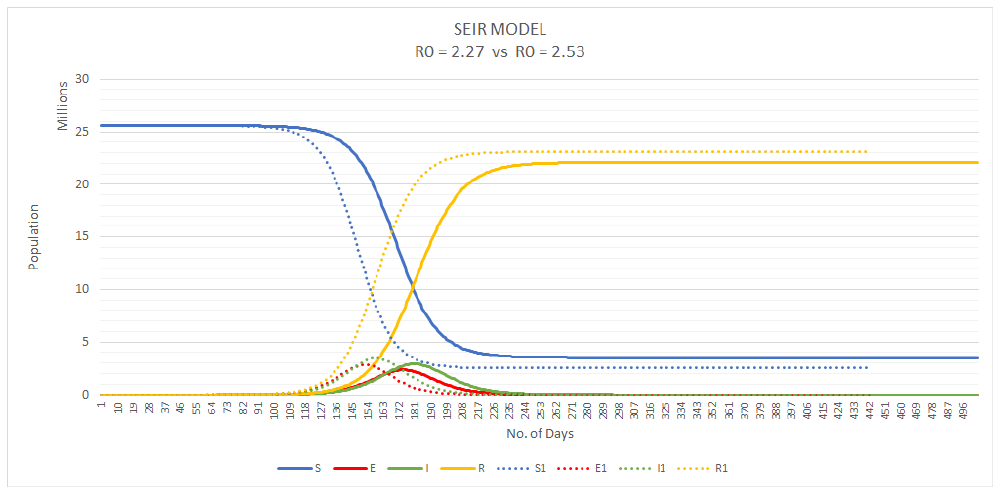
Figure 6. SEIR model predictions with basic reproductive number (R0) of 2.27 (solid lines) and 2.53 (dotted lines).